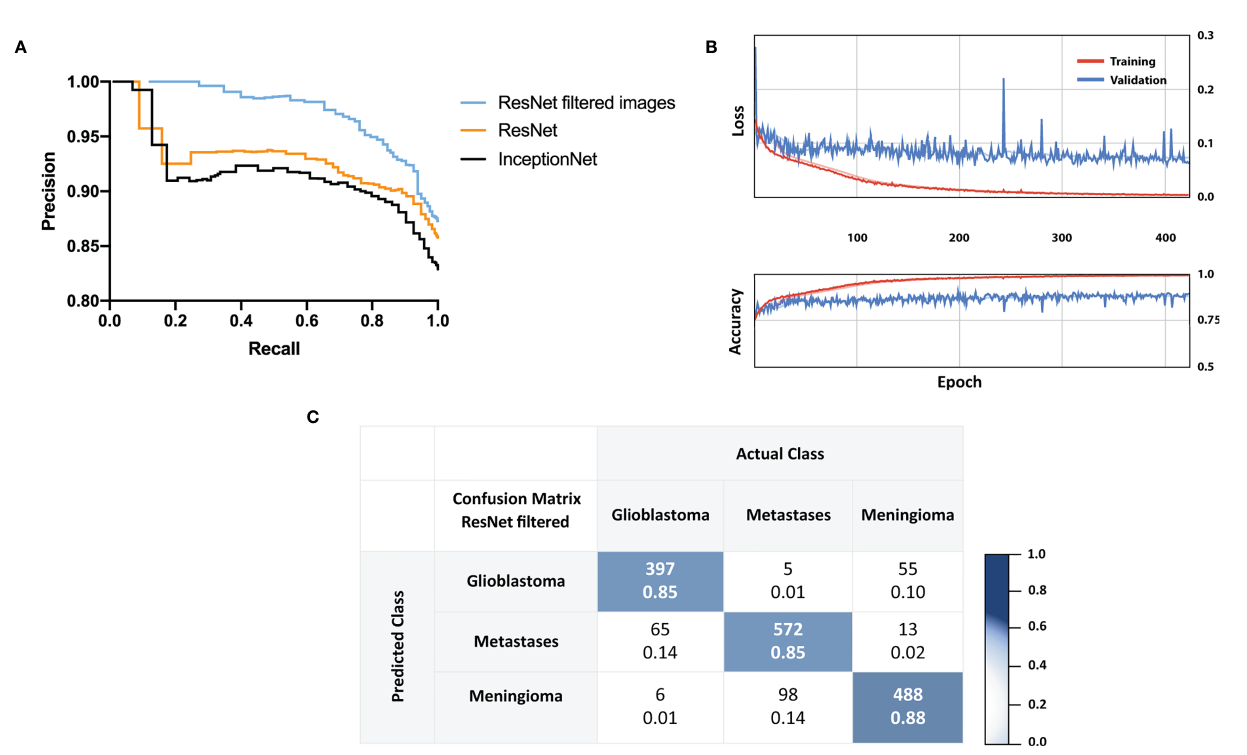
FIGURE 2 | (A) Test set results with Precision-Recall curves received for a trained three-class residual convolutional network, Inception network and a trained residual network with manually selected images. In (A) 12,273 images were used for training and 1,699 for the test set. In the preselected data set, 5,261 images were found suitable for training, and 647 were available for the test set. (B) Five-fold cross validation results. (C) Confusion matrix showing ResNet18 outputs and labeling of a test set using preselected images after images including substantial artifacts were manually removed. Images were obtained with CLE following topical ex vivo staining with fl uorescein dye. In each cell, the number above is the count and the number below the normalized count.